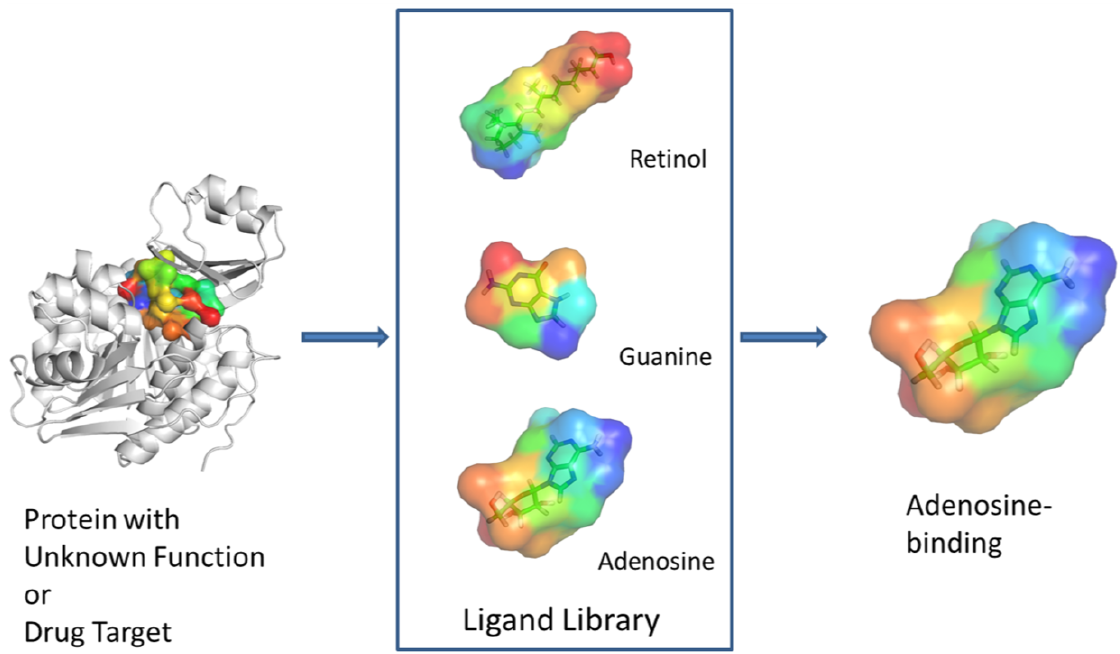
Figure 7. Overall scheme of